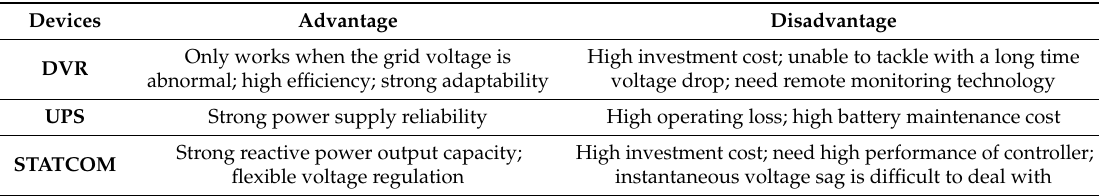
Table 1. Comparison between the main voltage sag compensation devices.